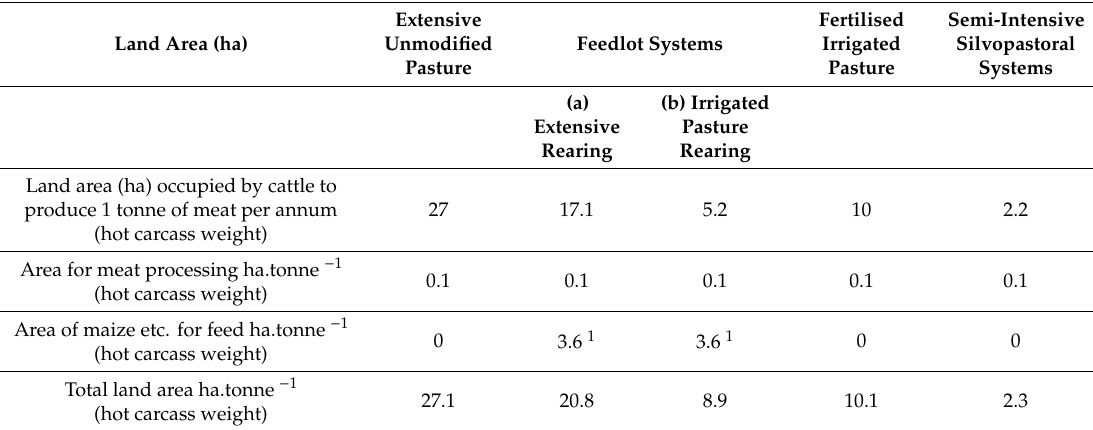
Table 1. Land usage in four beef production